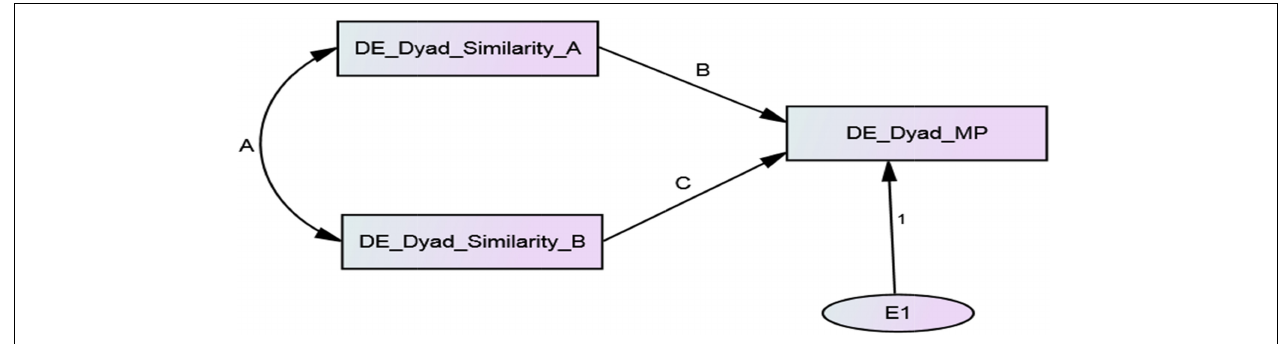
FIGURE 4 | Minimal dyadic ARRMA with double data entry with distinguishable